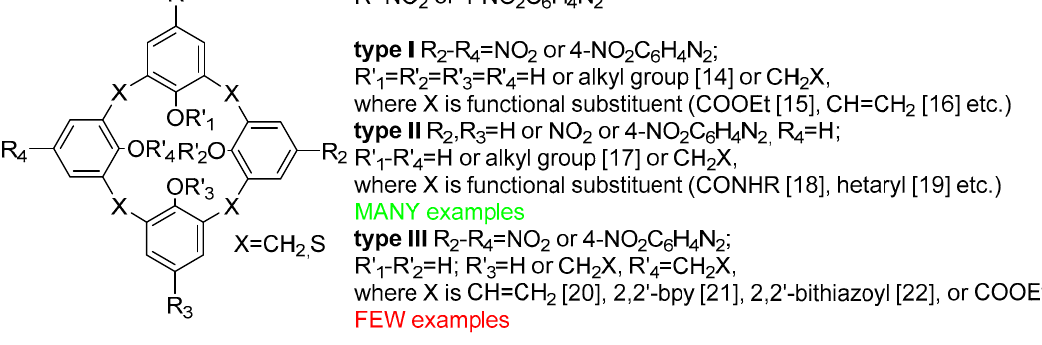
Figure 1. Substitution pattern on a nitro(thia)calix[4]arene scaffold.